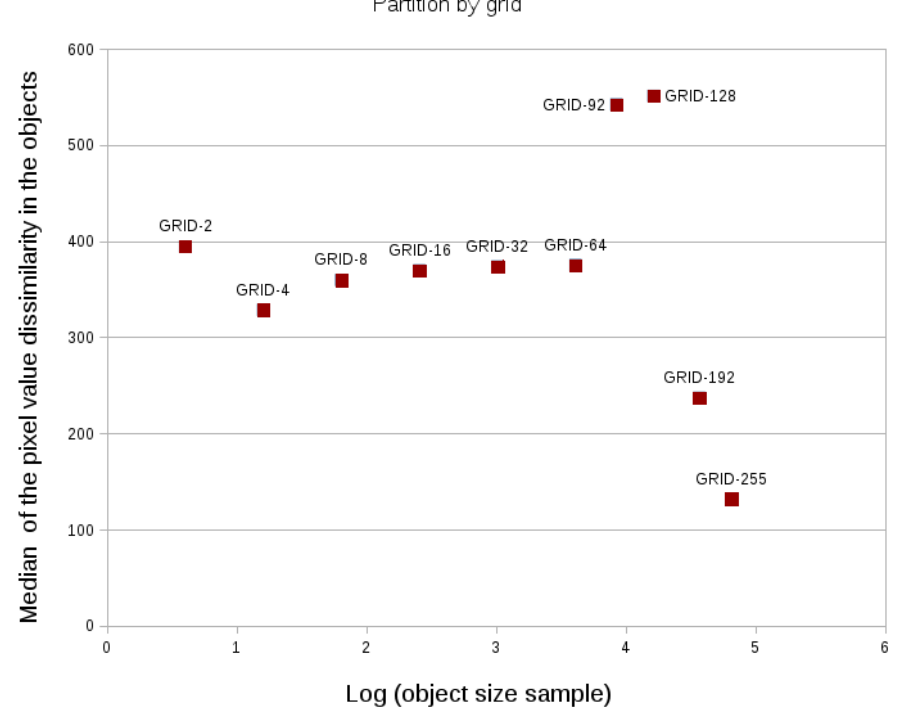
Figure 18. Median of the pixel value dissimilarity in objects with the partition using a